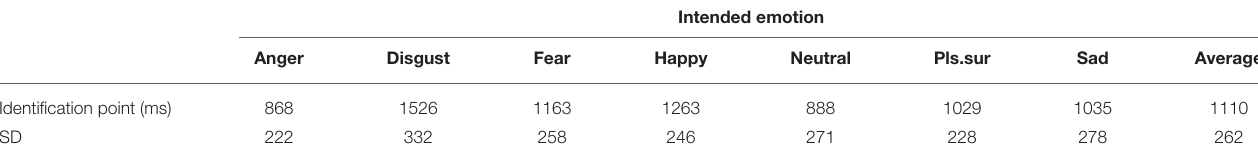
TABLE 6 | Identification points in milliseconds and SD for each emotion category and average identification point across all